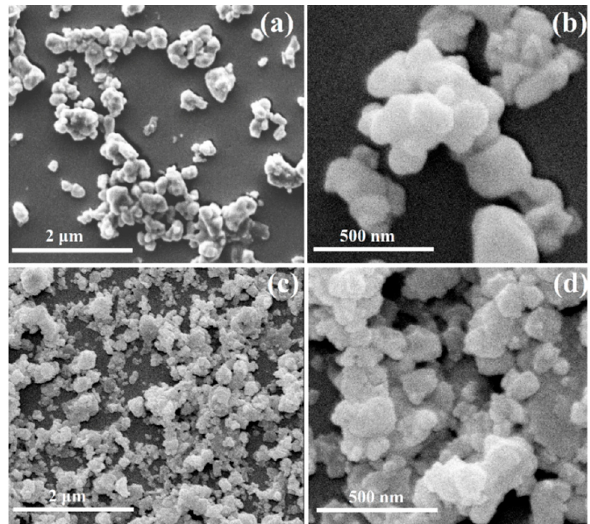
Figure 4. SEM images of the sprayed BiFeO 3 samples on a silicon substrate, with an initial powder with ( a , b ) no second milling, and ( c , d ) 8 h of second milling at different magnifications.